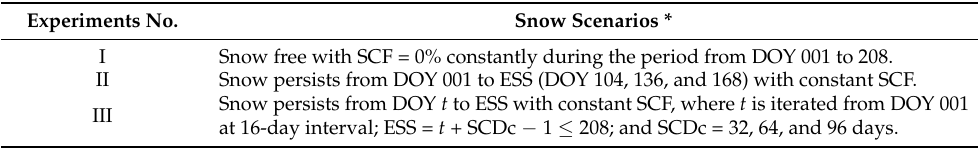
Table 2. Experimental settings for the investigation of the effect of snow on spring vegetation phenology detection.